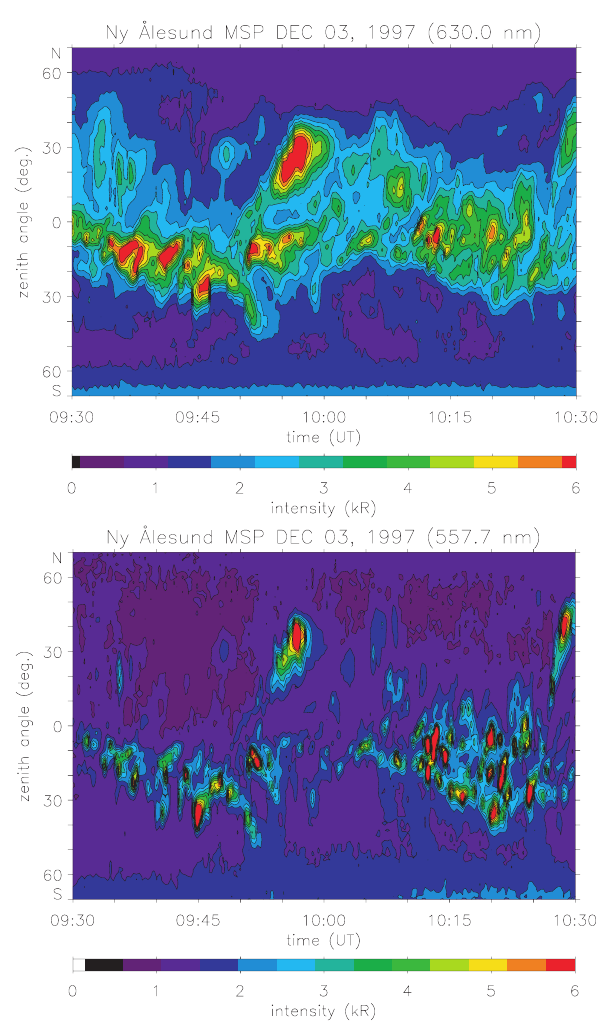
Fig. 8. MSP observations from Ny ˚Alesund during the interval 09:30–10:30 UT. The upper and lower panels show the red and green line emissions, respectively. Line of sight intensities are color-coded according to the scale the bottom of each